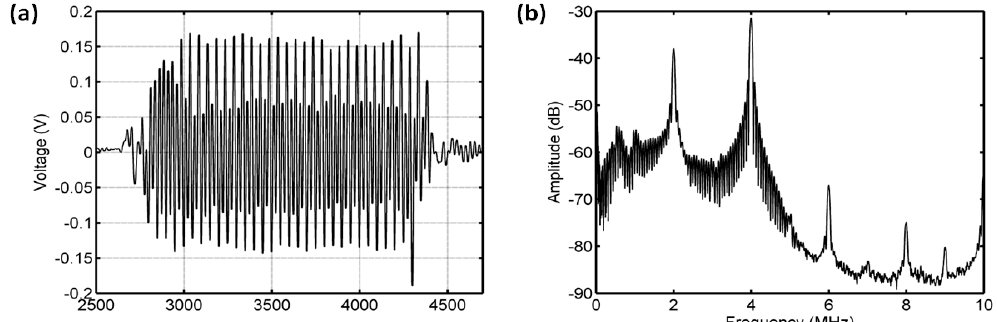
Figure 8. The measured scattering signals from microbubbles and the averaged power spectrum of 50 received signals. ( a ) A single received signal, ( b ) the averaged power spectrum. The driving frequency was 4 MHz, the acoustic pressure was 350 kPa, and the overpressure was 8 mmHg.